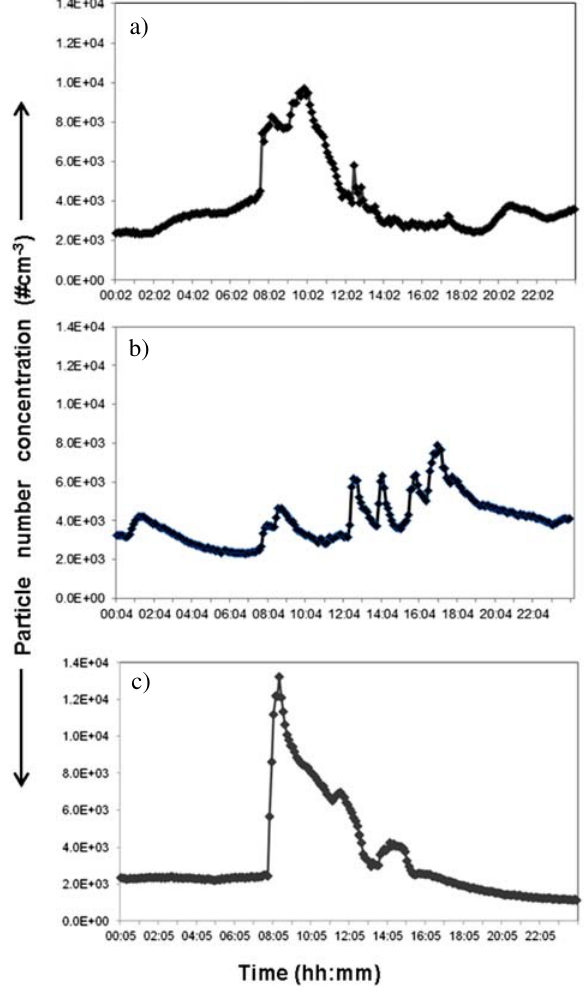
Figure 3: a) Total number concentration of particles between 15 and 750 nm measured on March 5, 2014 in the Room1 b) on March 10, 2014 in the Room 2 and c) in the Room 3, on March 21,